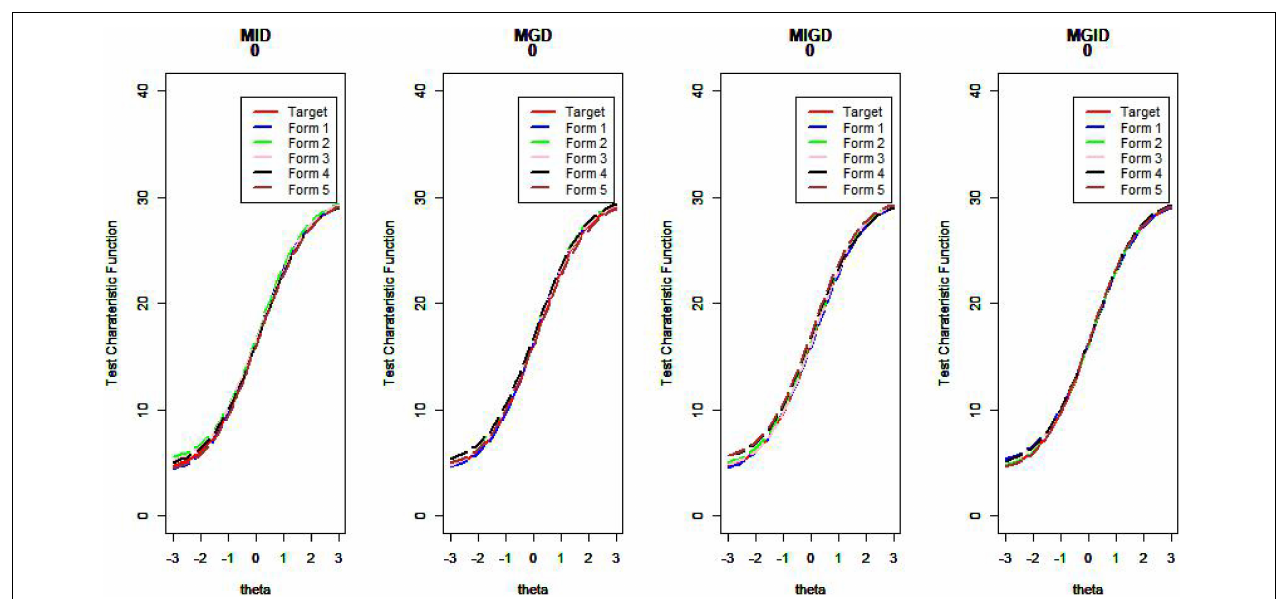
FIGURE 14 | Test characteristic curve ( D =